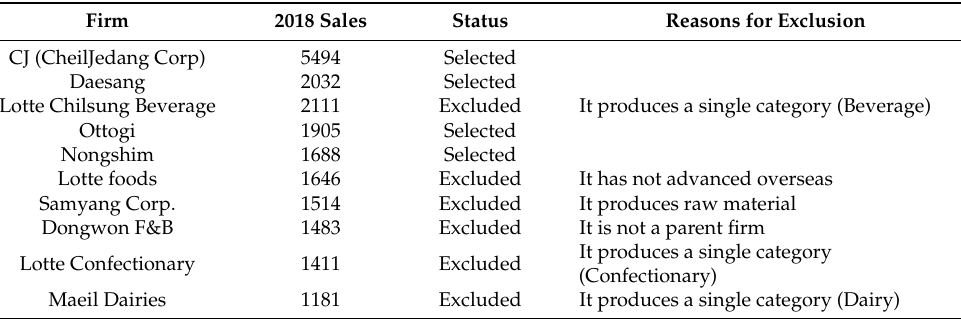
Table 1. List of selected and excluded food